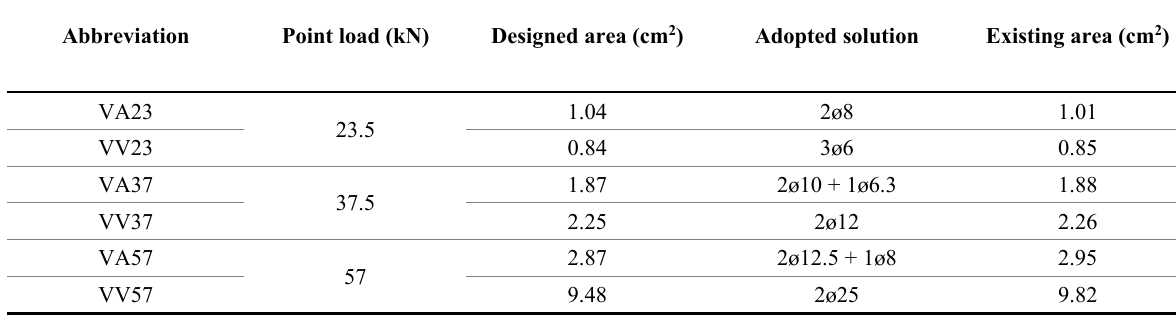
Table 4. Reinforcement area found in the design